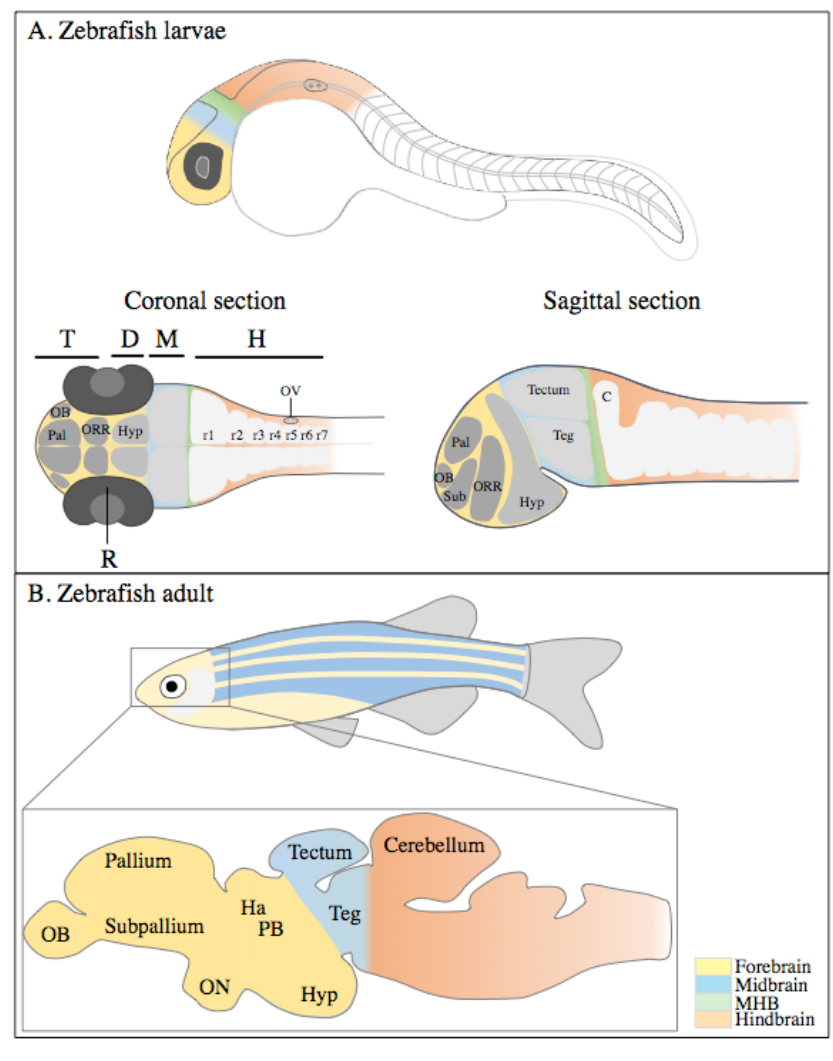
Figure 1. Development of the zebrafish brain. ( A ) Schematic representation of the embryonic brain (30 hpf), showing the forebrain (in yellow), midbrain (in blue), MHB (in green), and hindbrain (in orange). Coronal and sagittal section schemes show brain structures primordia. Forebrain is subdivided in the telencephalon (in darker gray) and the diencephalon (containing the hypothalamus, lighter grey). ( B ) Simplified representation of the adult brain and main domains. Drawings not to scale. Adapted from [42]; C: cerebellum; D: diencephalon; M: midbrain; MHB: midbrain ‐ hindbrain